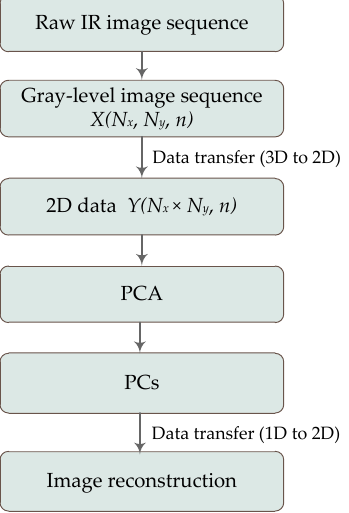
Figure 2. Schematic diagram of principal component analysis (PCA)-based image reconstruction.